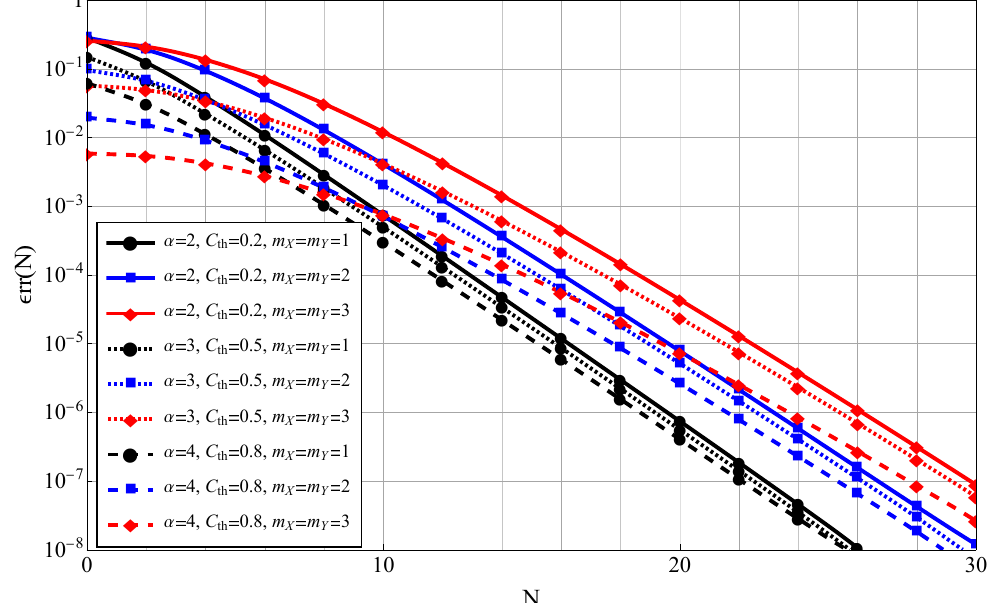
Figure 1. Error analysis of the derived expression (19) with Ω X = Ω Y = 0 dB, ¯ γ M = 10 dB and d W / d M = 1.